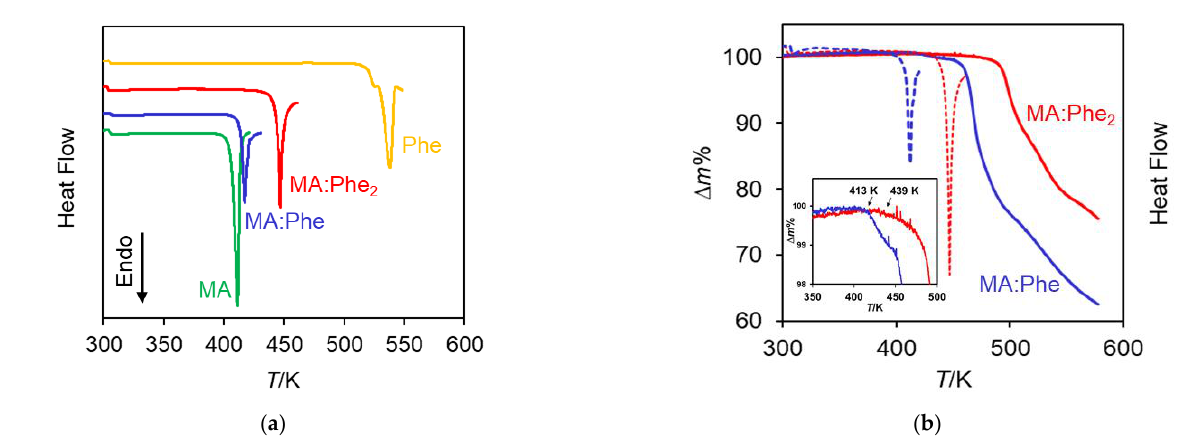
Figure 5. ( a ) Typical DSC results for MA:Phe, MA:Phe 2 , MA(cr I), and Phe(cr I): ( b ) overlay of DSC and TG curves for MA:Phe and MA:Phe 2 (the inset shows the beginning of the mass loss events). All experiments were carried out at a heating rate of 5 K∙min −1 . Table 2. Results of the differential scanning calorimetry (DSC) experiments on MA(cr I), Phe(cr I), MA:Phe, and MA:Phe 2 . a Compound MA(cr I) Phen(cr I) MA:Phe MA:Phe 2 T on /K Dec. Dec. Dec. Dec.